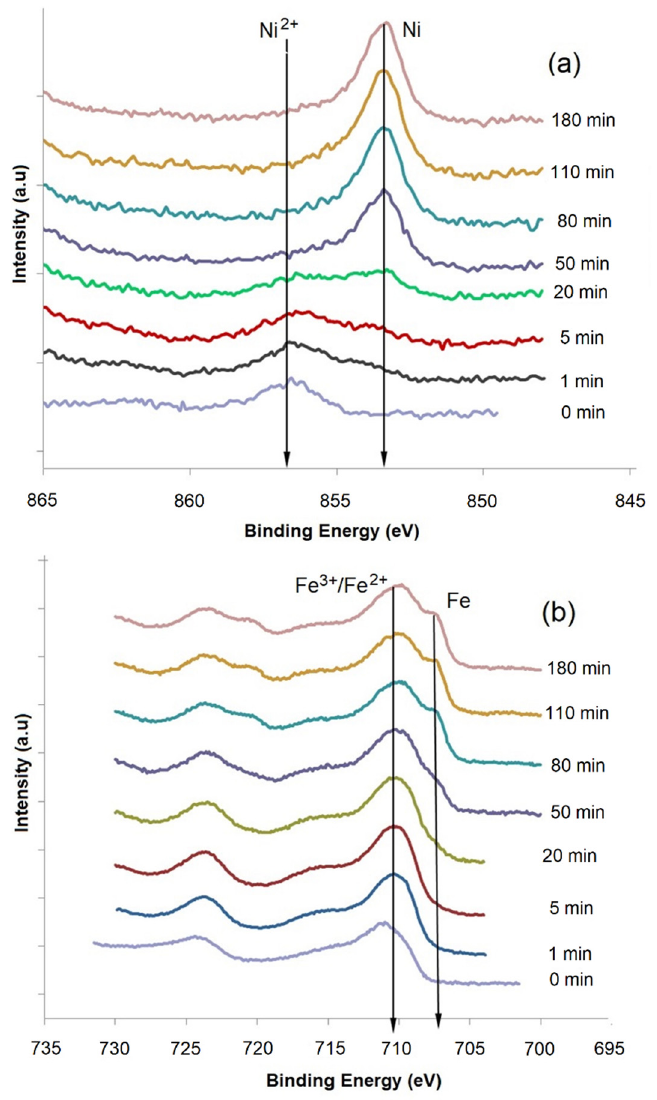
Figure 5. Individual XPS spectra of nickel ( a ) and iron ( b ) in the coating on a steel substrate, depending on the duration of etching.